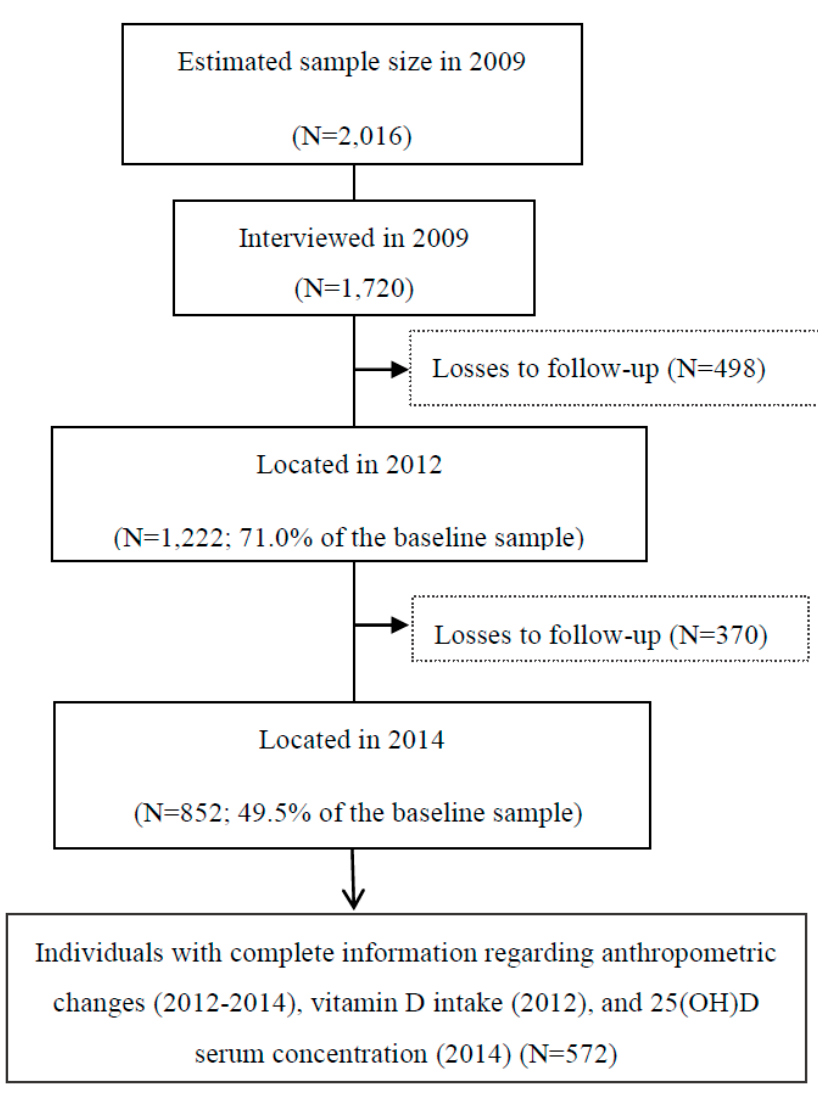
Figure 1. Flowchart of the follow-ups (2009–2012–2014) in the EpiFloripa Adults cohort study. Florianópolis, Santa Catarina, Brazil.